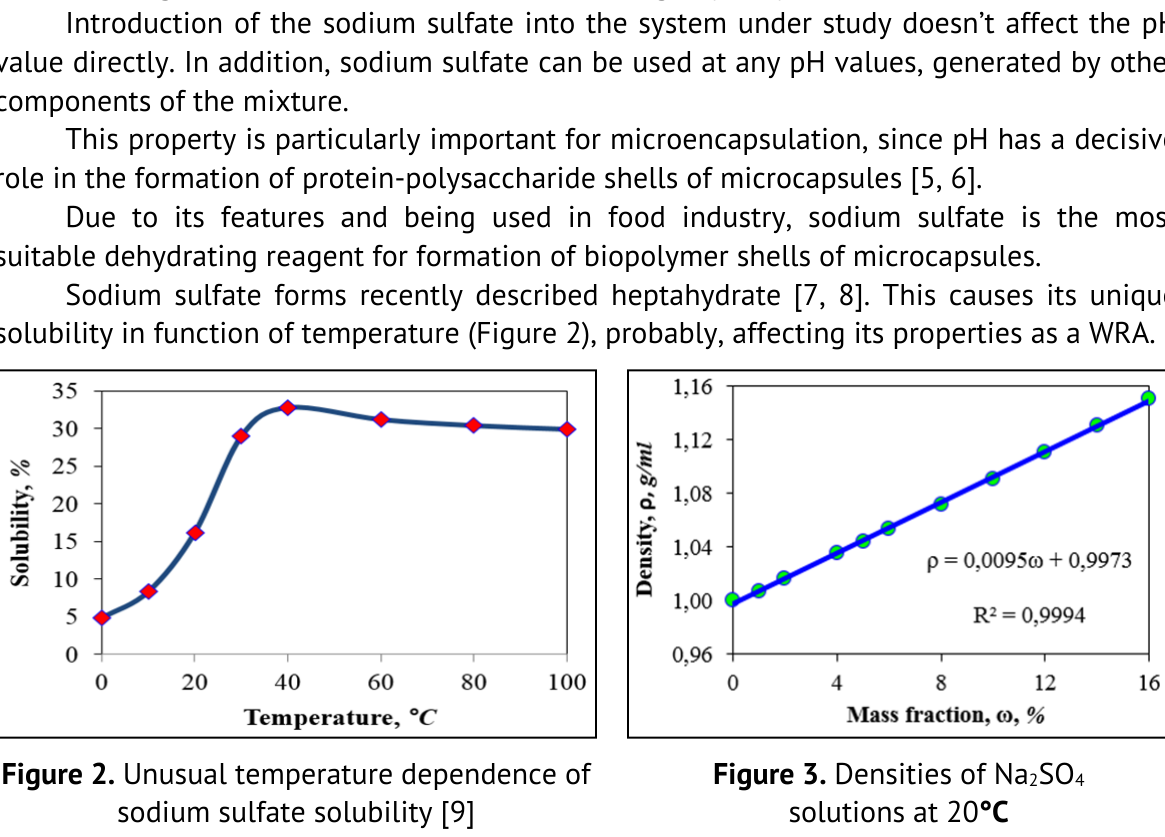
Figure 2. Unusual temperature dependence of sodium sulfate solubility [9]